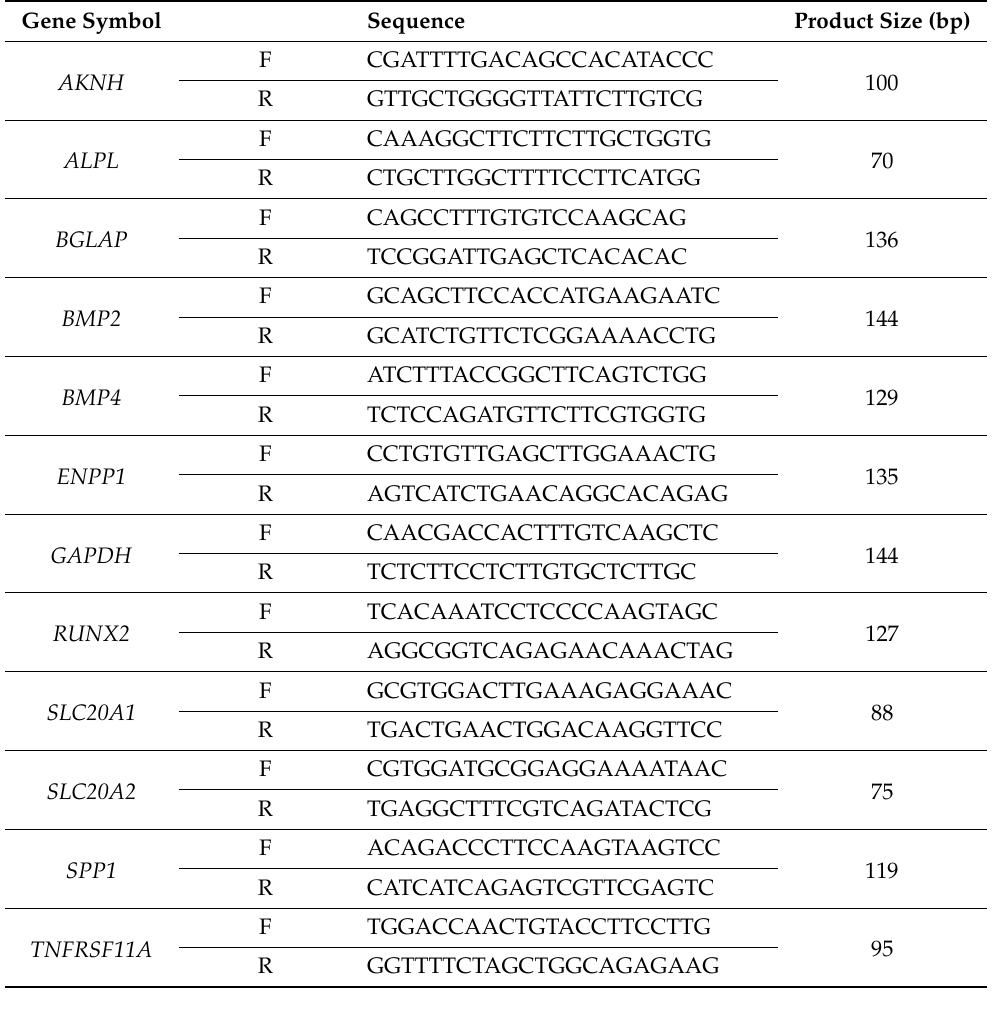
Table 4. Real-time PCR primer